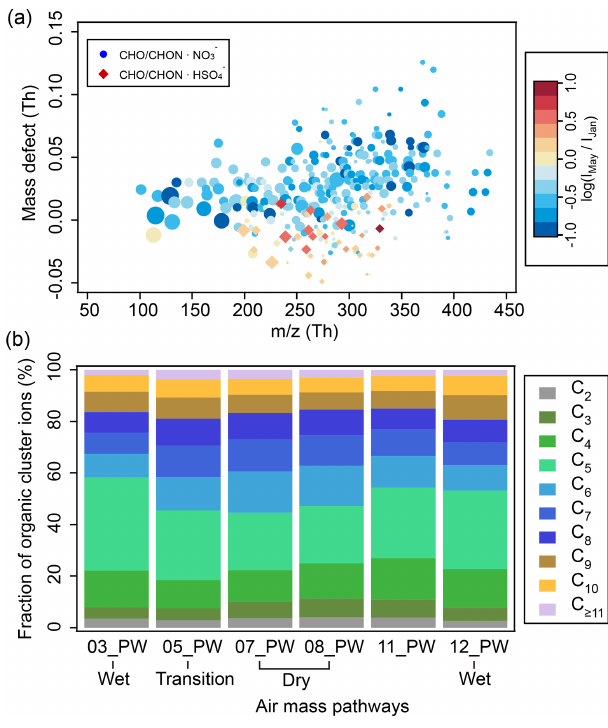
Figure 7. (a) Mass defect plot of organic cluster ions during night- time (19:00–07:00). The color code indicates ratios (in log scale) between the median signals of each ion detected in May ( I May ) of the dry season and January ( I Jan ) of the wet season. The marker size is proportional to the log-transformed median signals of ions in May. (b) Fraction of organic cluster ions from different air mass pathways as a function of carbon atom numbers during nighttime (19:00–07:00). A similar figure based on daytime data (07:00– 19:00) is in the Supplement (Fig. S7). Note that MA-derived ions were not included in this